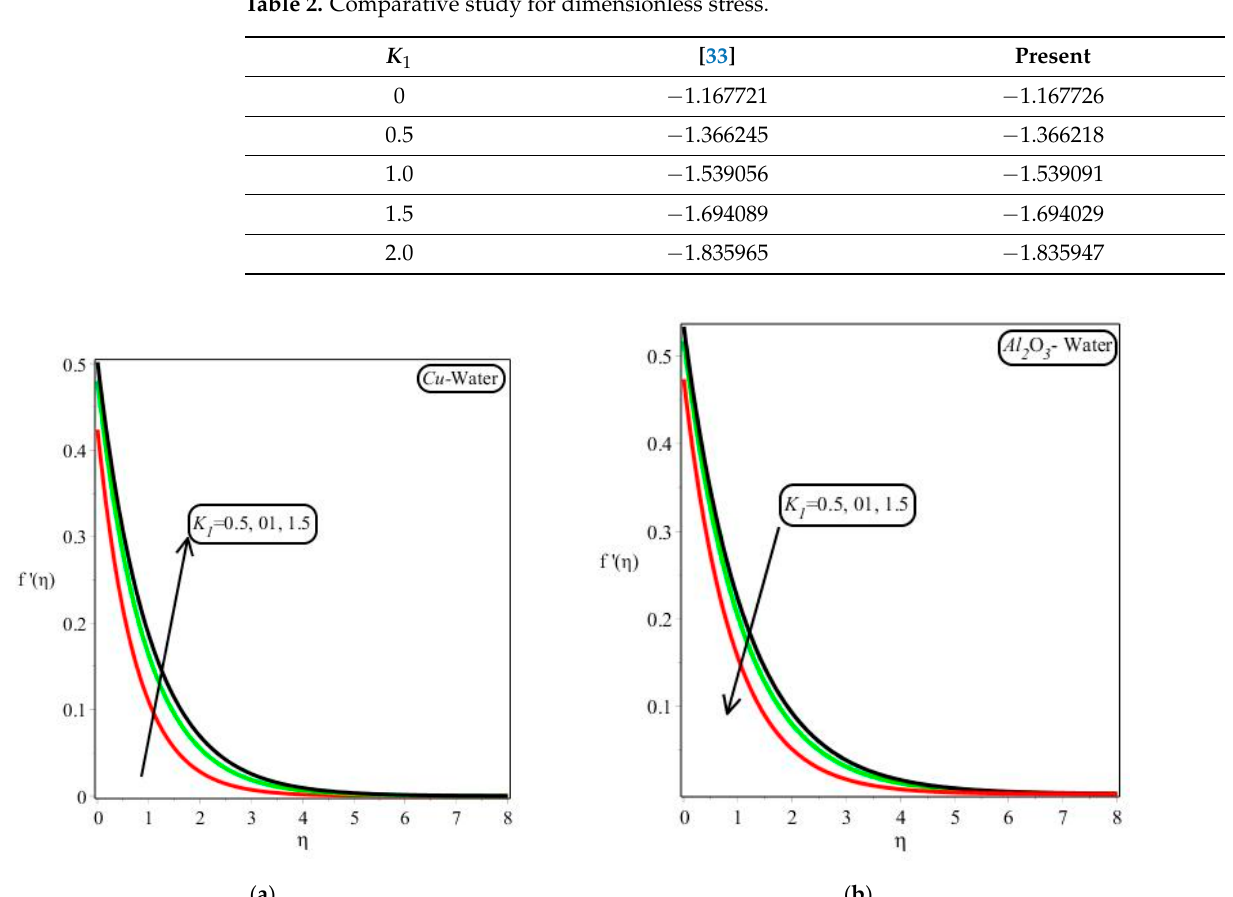
Figure 2. ( a , b ) Impact of K 1 on velocity profile with β = 1, γ = π /3, φ = 0.2, and M = 0.2.